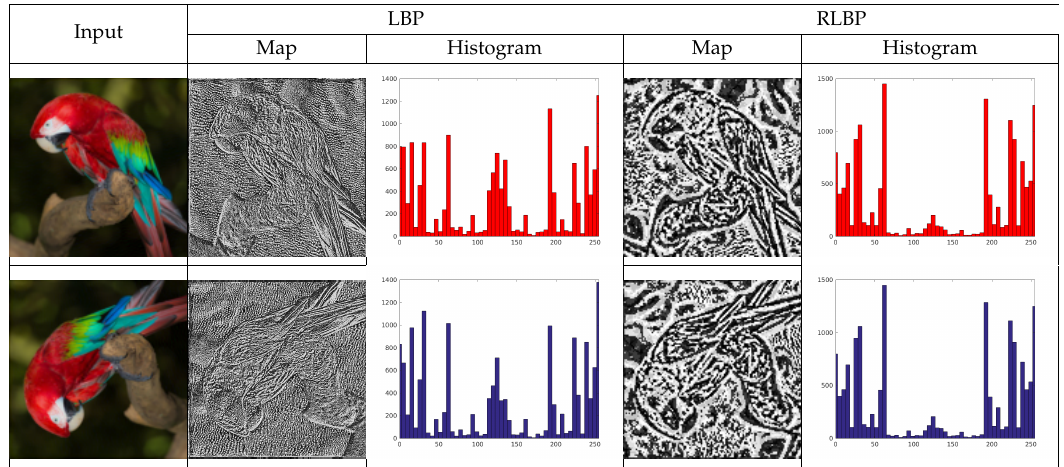
Figure 8. Effect of rotation on LBP and RLBP information.